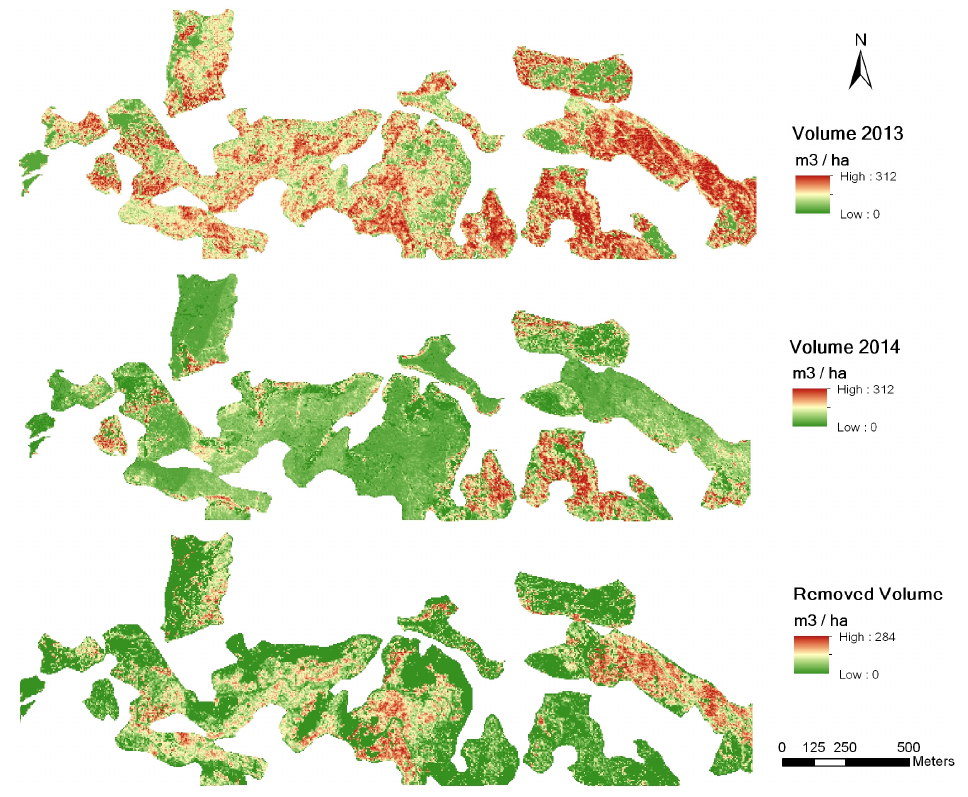
Figure 6. The distribution of understorey volume before and after forest tending, and the variation in understorey volume caused by forest tending.